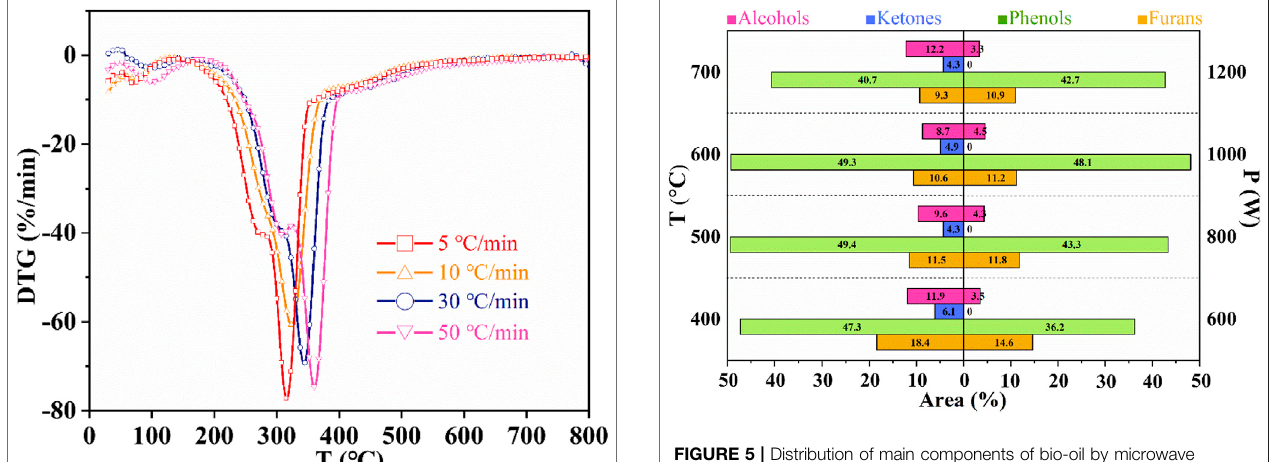
FIGURE 5 | Distribution of main components of bio-oil by microwave pyrolysis of CS at different temperatures and power.